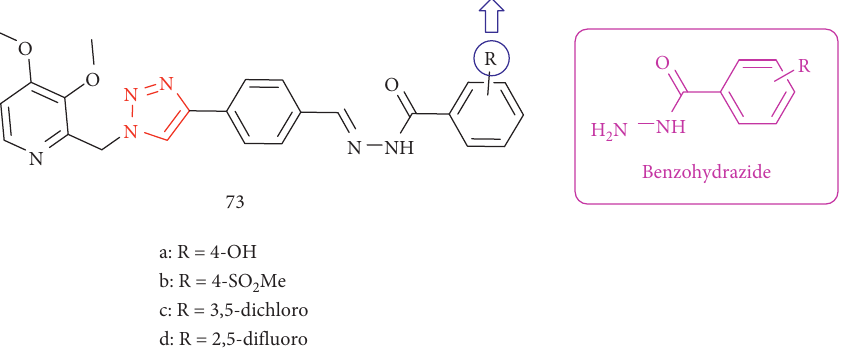
Figure 26: Chemical structure of novel 1,2,3-triazole-carbohydrazide